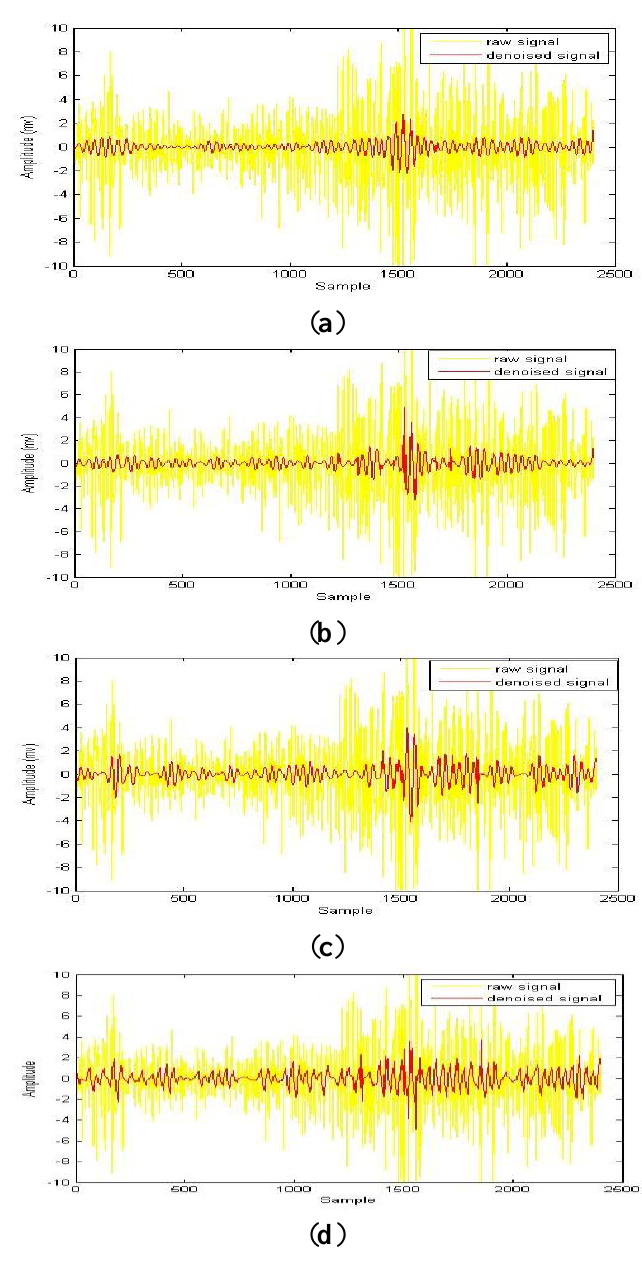
Figure 2. Raw EMG signal denoised by wavelet function ( a ) db2; ( b ) db4; ( c ) db6; ( d ) db44; ( e )